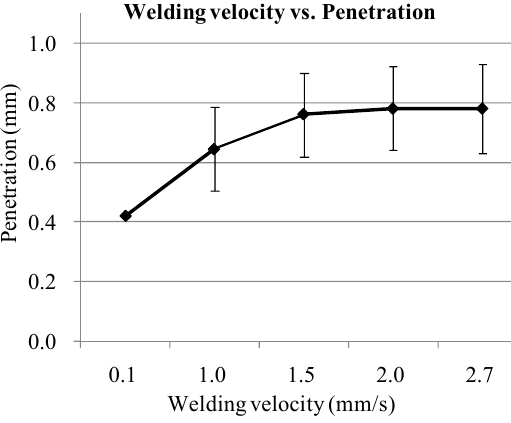
Figure 15. Effects of welding velocity on penetration.